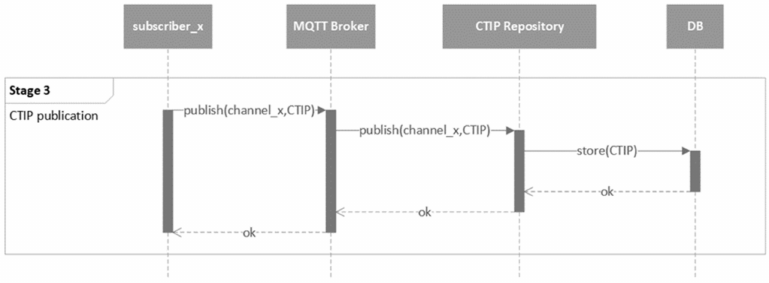
Figure 12. UML behavioral diagram of the CTIP publication stage (stage 3).